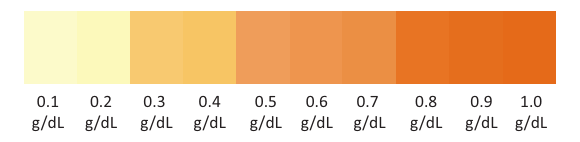
FIGURE 2: Visual haemoglobin colour scale printed on 230 gsm (grams per square metre) glossy laminated photo paper using a three-colour laser printer. The scale was developed at the Quality Control Department of the National Blood Center, Sri Lanka, September 2020 – May 2021.